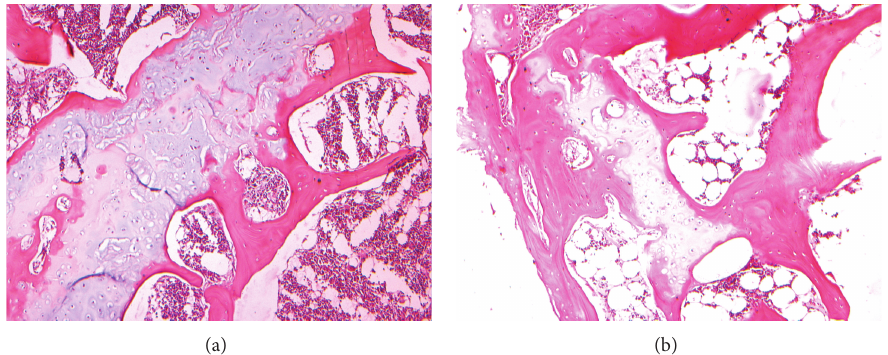
Figure 3: (a) Large quantity of chondrocytes growing in cluster after PMMA injected 4w, HE × 100. (b) Chondrocytes in cluster without conspicuous inflammation after PMMA injected 4w, HE × 100.